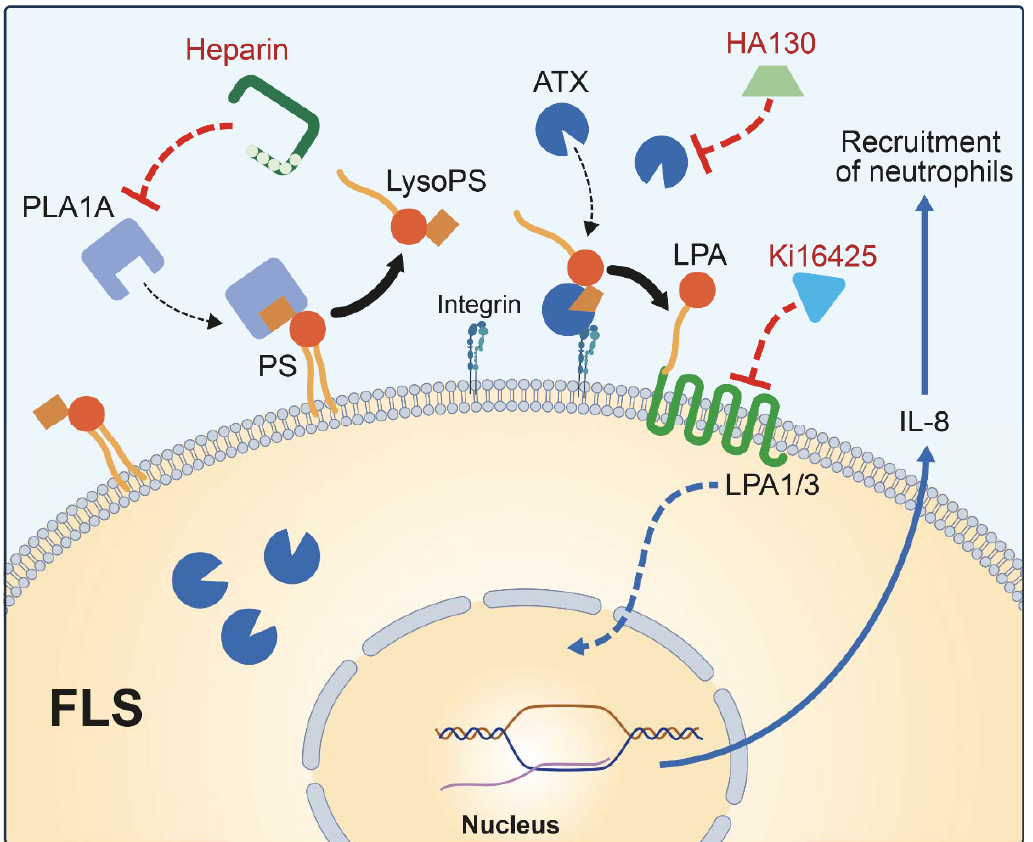
Figure 7. Schematic illustration of IL-8 production in FLSs stimulated with PLA1A. Activated FLSs exposed PS on outer leaflet of cell membrane and presented this specific lipid substrate to extracellular PLA1A to produce lysoPS, which was subsequently converted by additional or FLSs-secreted ATX to produce LPA. LPA stimulated IL-8 production in an autocrine manner through activating LPA1/3 associated signaling pathway. IL-8 is a neutrophil chemotactic factor that plays a role in inflammation. Added heparin competitively bound to PLA1A to prevent surface-exposed PS from hydrolyzation. ATX inhibitor HA130 and LPA1/3 antagonist Ki16425 decreased secretion of IL-8 in FLSs through inhibiting ATX-LPAR axis.